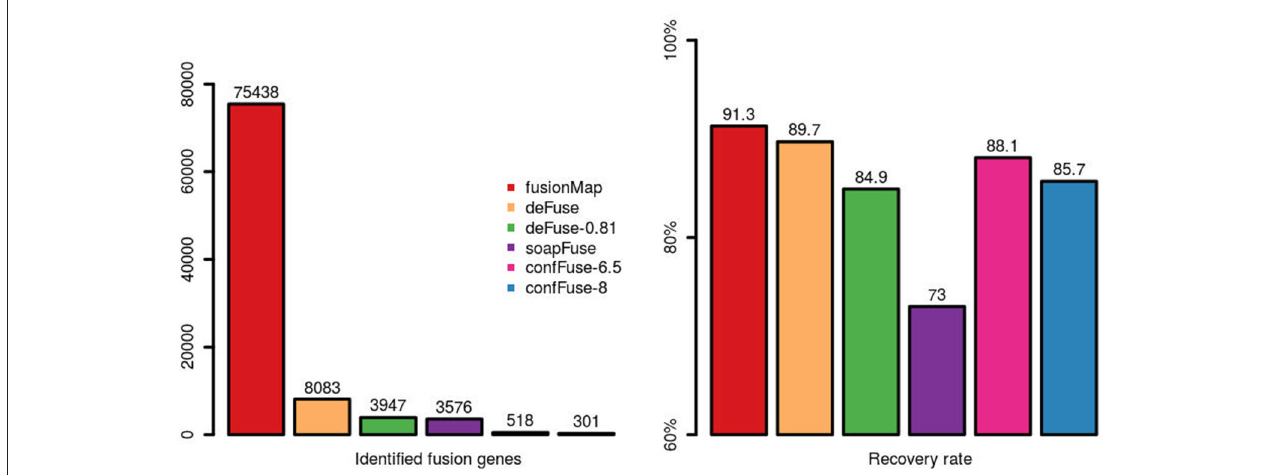
FIGURE 7 | Identified fusion genes and recovery rate of validated fusions among different tools. One hundred and twenty-six fusions were previously validated by RT-PCR. Five methods (fusionMap, deFuse, deFuse-0.81, confFuse-6.5, and confFuse-8) performed similarly in terms of recovery rate. confFuse generated much less fusion candidates than the others (higher specificity) while identifying comparable number of validated fusions (similar sensitivity).